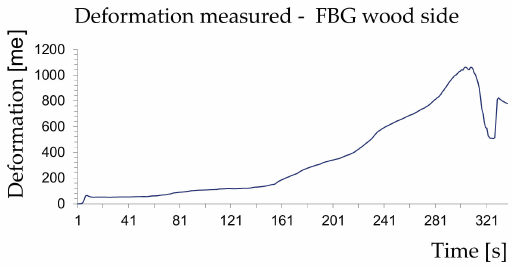
Figure 10. Deformations measured by the FBG in contact with the wood.